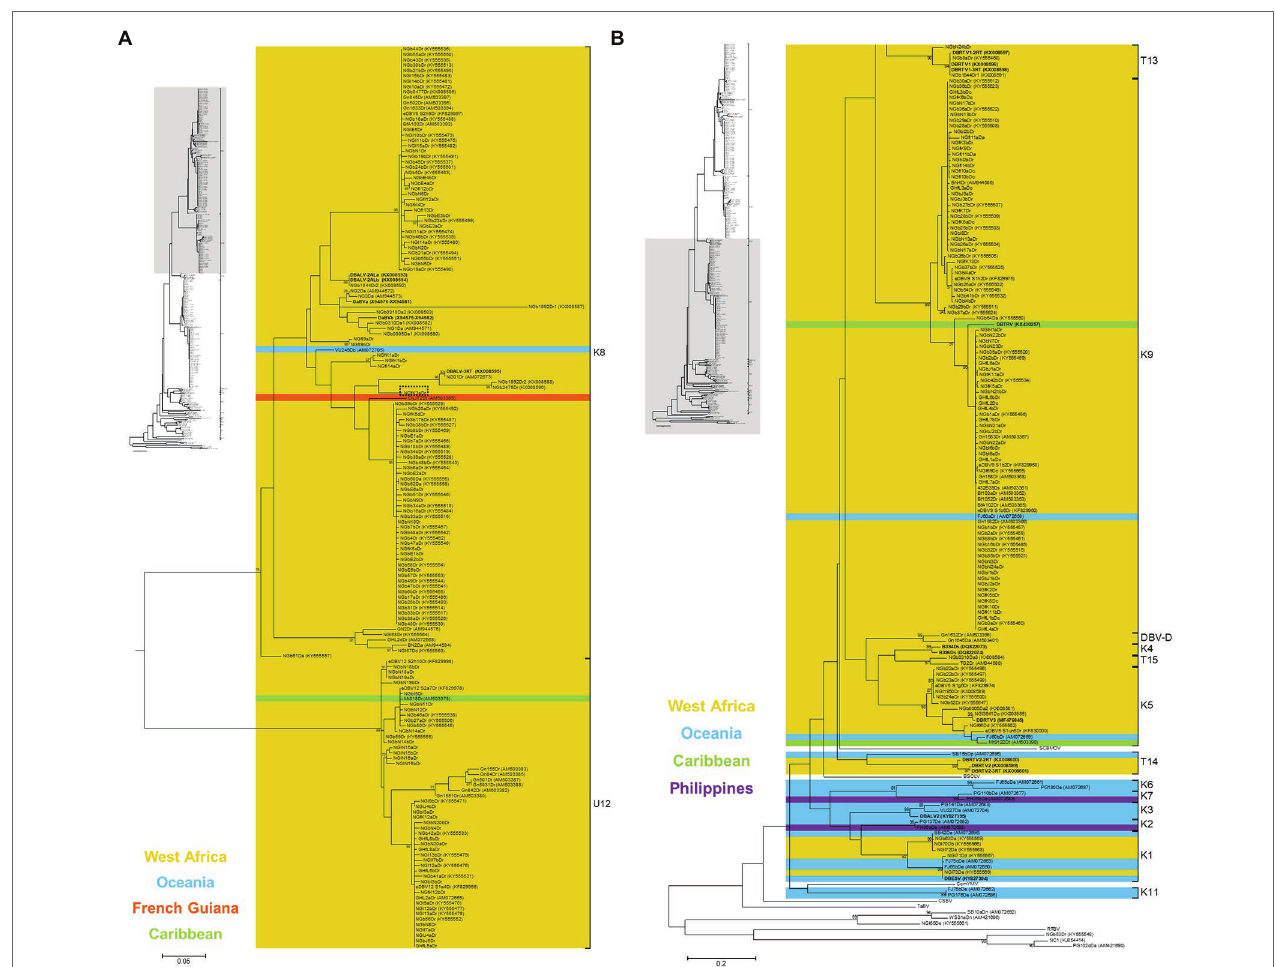
FIGURE 4 | Bootstrap consensus phylogenetic tree using Maximum Likelihood method built from 320 bp long partial RT-RNaseH nucleotide sequences of 135 yam badnavirus sequences determined in this study. Included in the analysis are partial RT-RNaseH sequences with names and GenBank accession numbers of previously analysed yam samples (Eni et al., 2008; Kenyon et al., 2008; Bousalem et al., 2009; Seal et al., 2014; Umber et al., 2014, 2017; Bömer et al., 2016; Sukal et al., 2017; Turaki et al., 2017). Equivalent sequences from cacao swollen shoot Togo A virus (CSSToAV, AJ781003), banana streak OL virus